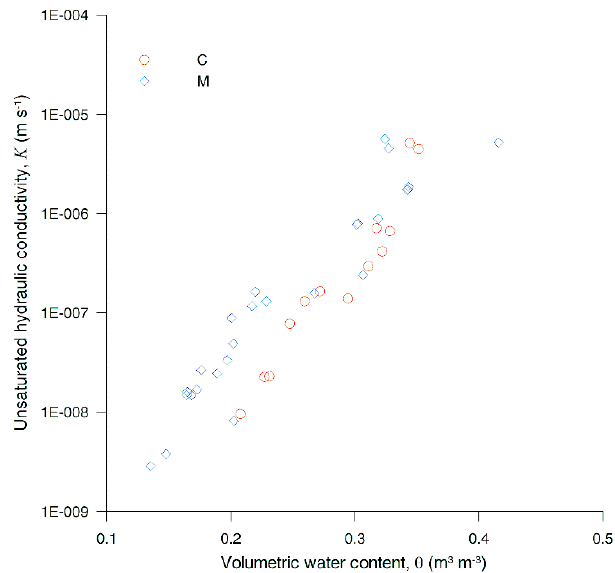
Figure 10. Hydraulic conductivity, K ( θ ), measured by the QSC method for lithotypes C and M.